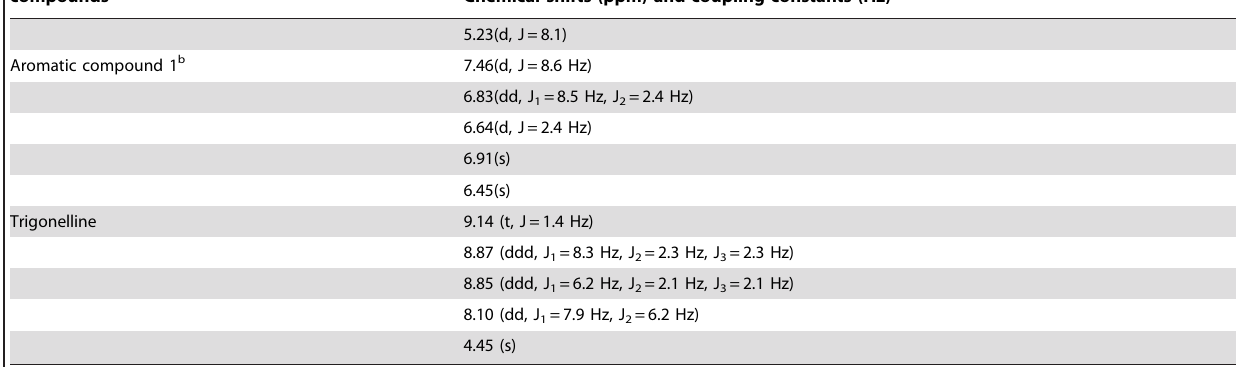
compounds Chemical shifts (ppm) and coupling constants (Hz)